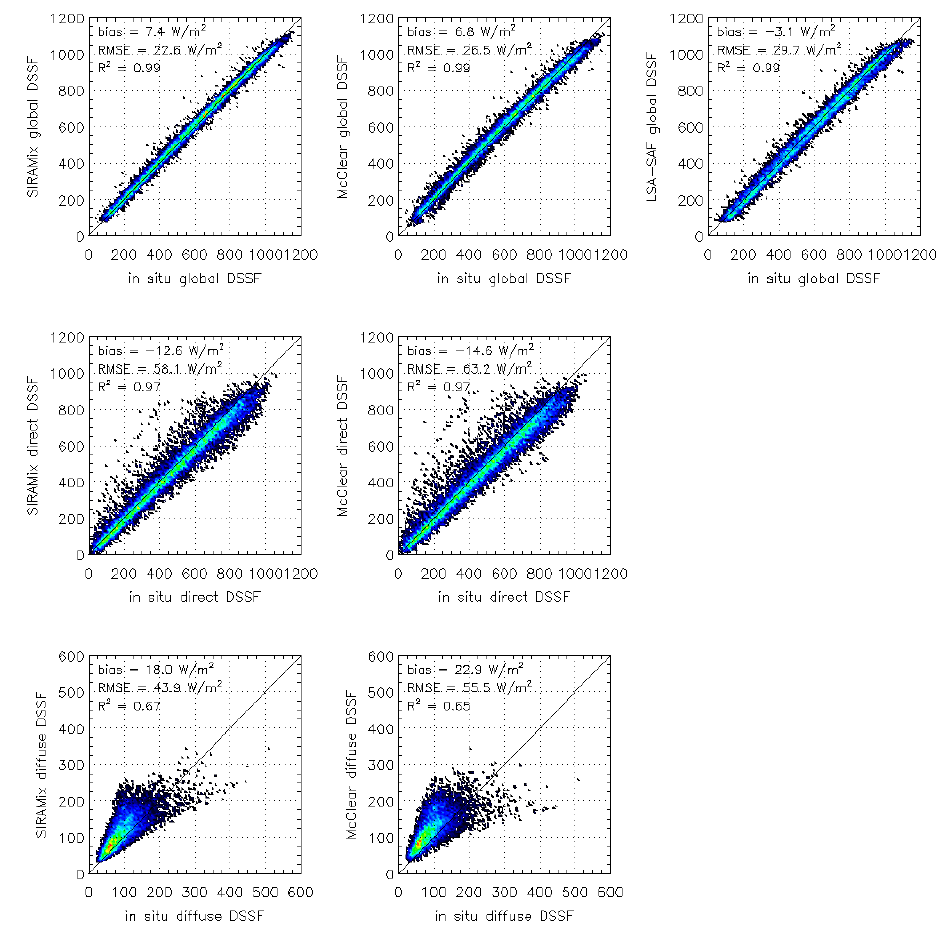
Figure 9. Scatter plots for global, direct, and diffuse DSSF obtained when the retrieval methods SIRAMix, McClear, and LSA-SAF are compared with coincident ground